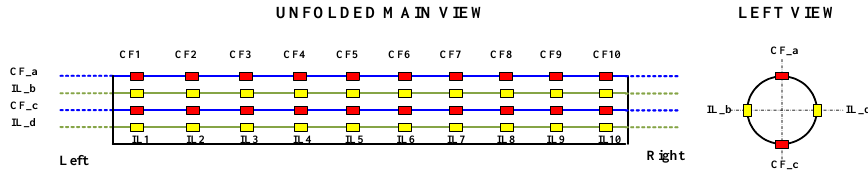
Figure 2. The Fiber Bragg Grating (FBG) strain sensor instrumentation along the flexible pipe model.